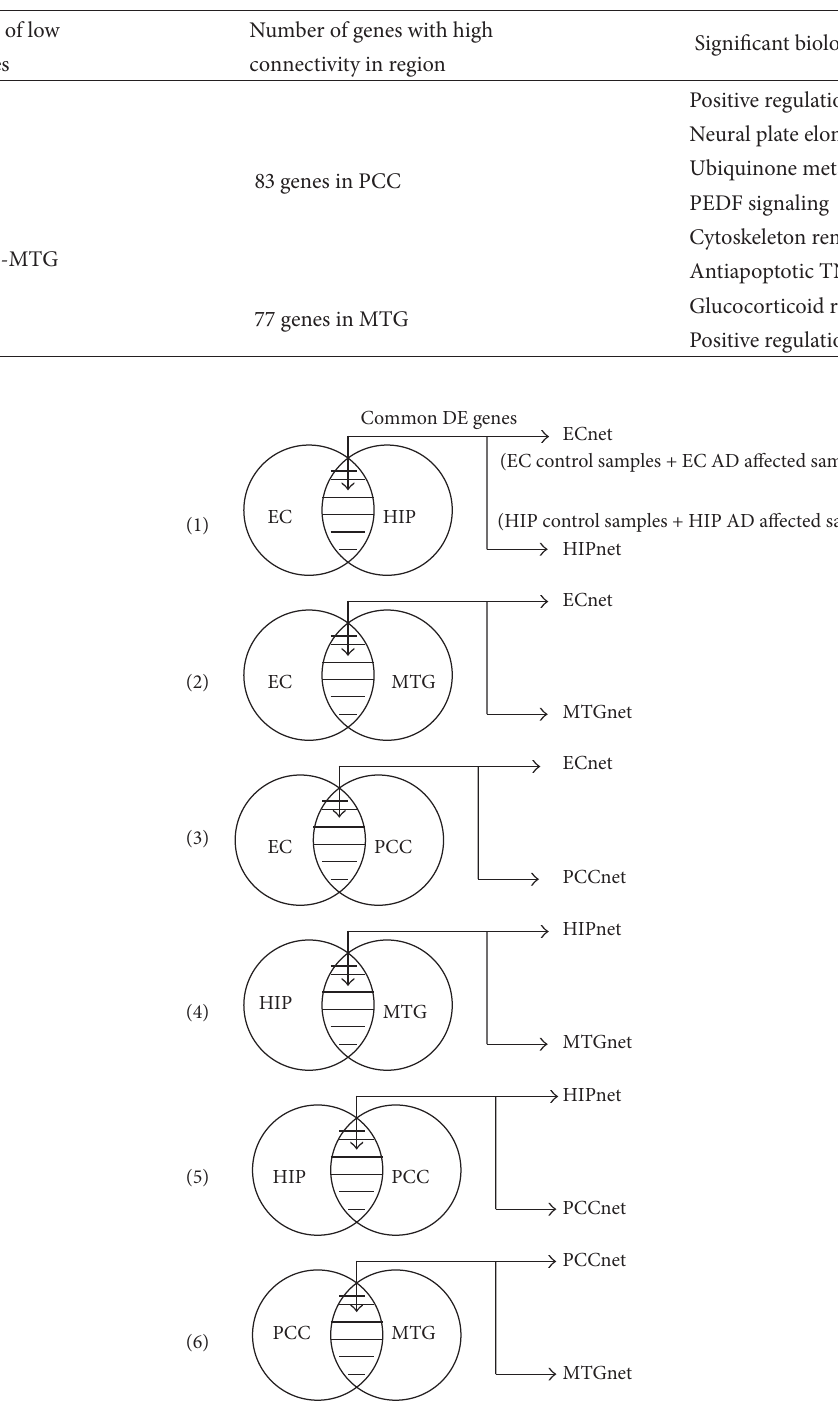
Figure 3: Regional coexpression networks construction diagram. Gene coexpression networks built from sets of differentially expressed genes. EC refers to the entorhinal cortex, HIP is hippocampus, MTG is the middle temporal gyrus, and PCC is posterior cingulate cortex. For each of the 6 comparisons, the coexpression network was built using the common differentially expressed genes between the two regions and the samples from that specific region. For instance, when the EC and HIP were being compared, the 2041 common DE genes between EC and HIP were used to construct the ECnet using the control and the AD affected samples from the EC, while the HIPnet was constructed on the same set of 2041 DE genes but the control and AD affected samples were from the HIP. This kind of analyses results in 12 coexpression networks—2 per regional